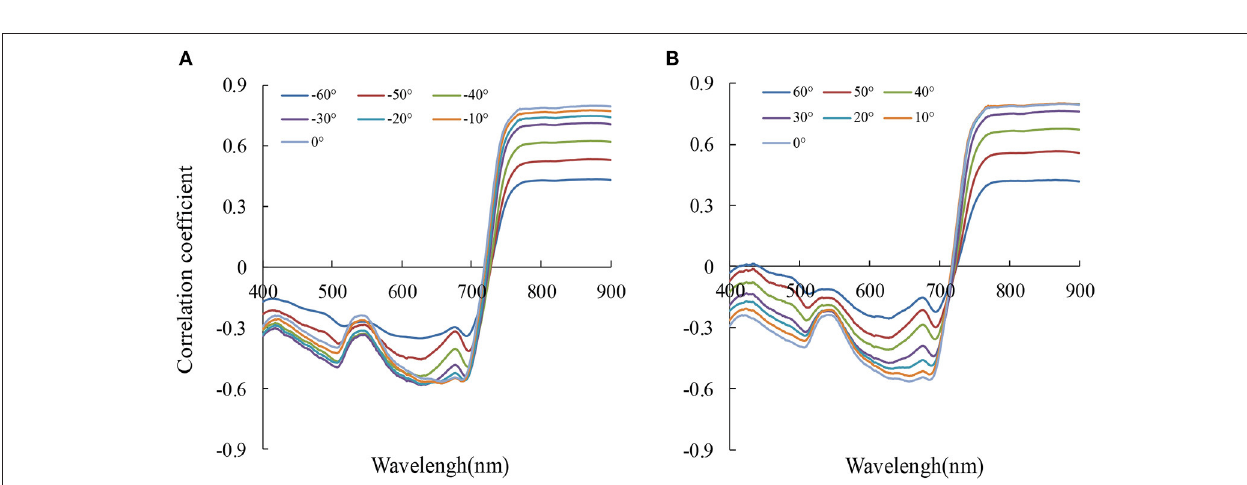
FIGURE 7 | The correlation coefficient ( r ) between reflectance ( R x ) and aerial N uptake at 13 viewing zenith angles ( A : backward scattering, B : forward scattering) ( n = 155, p 0.001 =